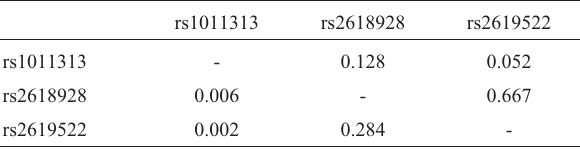
Table 6 - Pairwise linkage disequilibrium (LD) results.